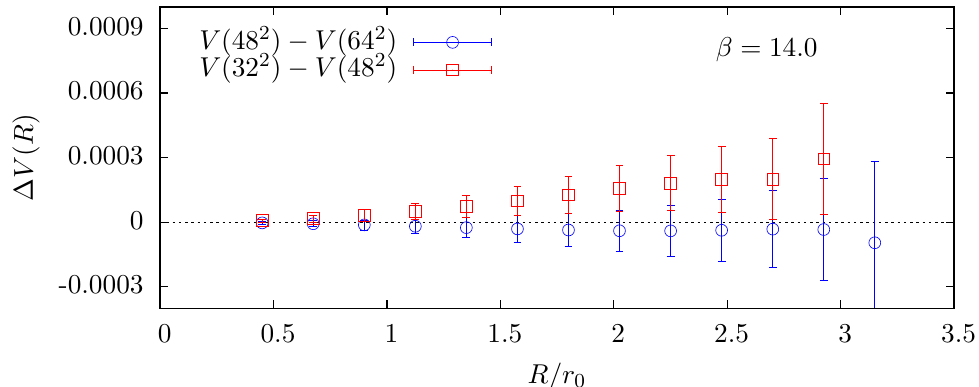
Figure 10 . Di(cid:11)erence in the results for the static potential (cid:1) V from volumes 48 2 and 64 2 (blue circles) and 32 2 and 48 2 with N t = 48 versus the q (cid:22) q -separation in units of r 0 at a temporal extent of 48 and (cid:12) = 14 :